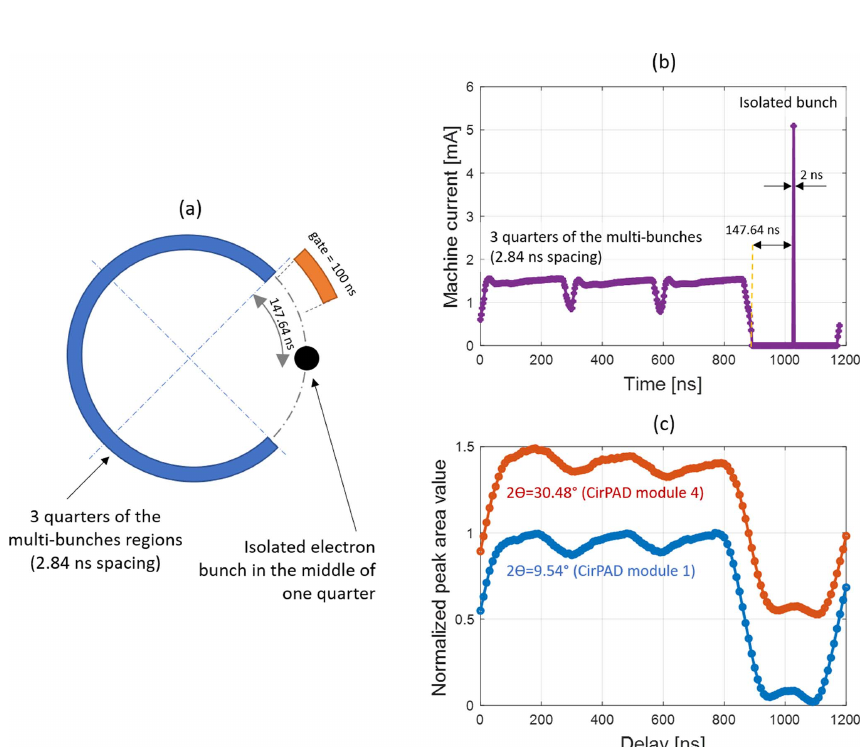
Figure 14 ( a ) Schematic view of the bunch distribution in the hybrid-filling mode at Synchrotron SOLEIL. ( b ) The corresponding machine current distribution. ( c ) Example of the intensity reconstructed for two diffraction peaks (2 (cid:2) = 9.54 and 30.48 (cid:3) , thus two different CirPAD modules). Each point corresponds to a different delay value separated by a 10 ns step. The intensity corresponds to the integrated signal (area) over the corresponding XRD peak from the LaB 6 powder. Data sets are scaled and shifted vertically for better